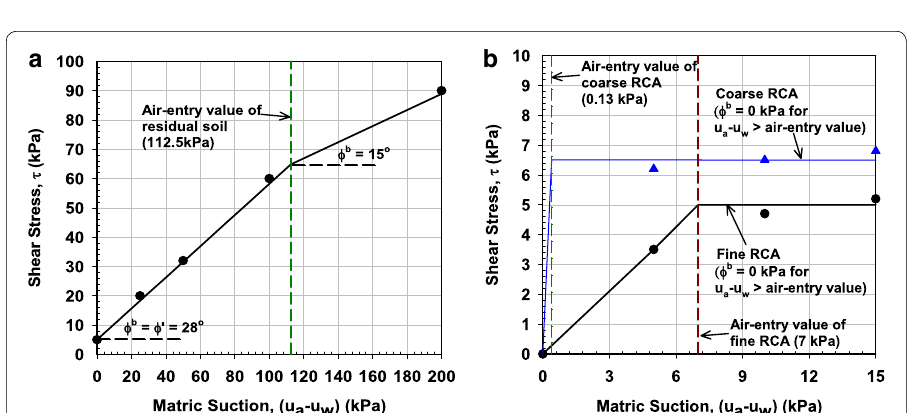
Fig. 12 Unsaturated shear strength of a residual soil and b fine and coarse